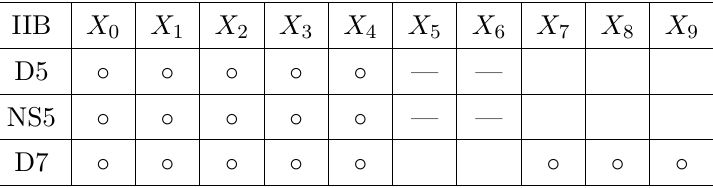
Table 1 . The brane configuration of ( p, q ) -5-brane with D7-branes. The ( p, q ) -5-brane web is defined on the X 5 , 6 -plane denoted by bar.